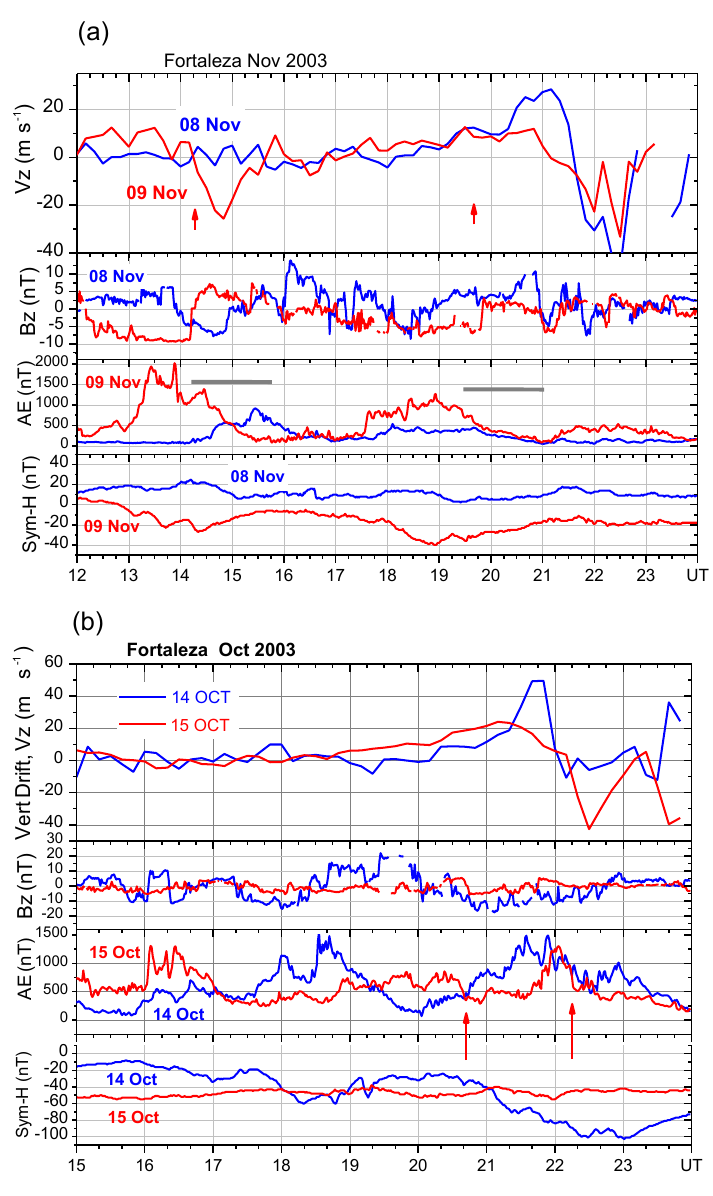
Figure 5. (a) The variations during 8 (blue curve) and 9 (red curve) November 2003 in the vertical drift over Fortaleza (top panel); the interplanetary magnetic field component B z (panel 2); the AE activity index (panel 3); and the Sym-H/Dst index (bottom panel). The dark horizontal bars in panel 3 indicate the approximate durations of the two cases of over-shielding effects on 9 November. (b) The variations during 14 (blue curve) and 15 (red curve) October 2003 in the vertical drift over Fortaleza and the B z , AE index, and Sym-h/Dst indices, in the same format as in (a) . Here the two vertical red arrows indicate the onsets of over-shielding effects on the evening of 15 October.